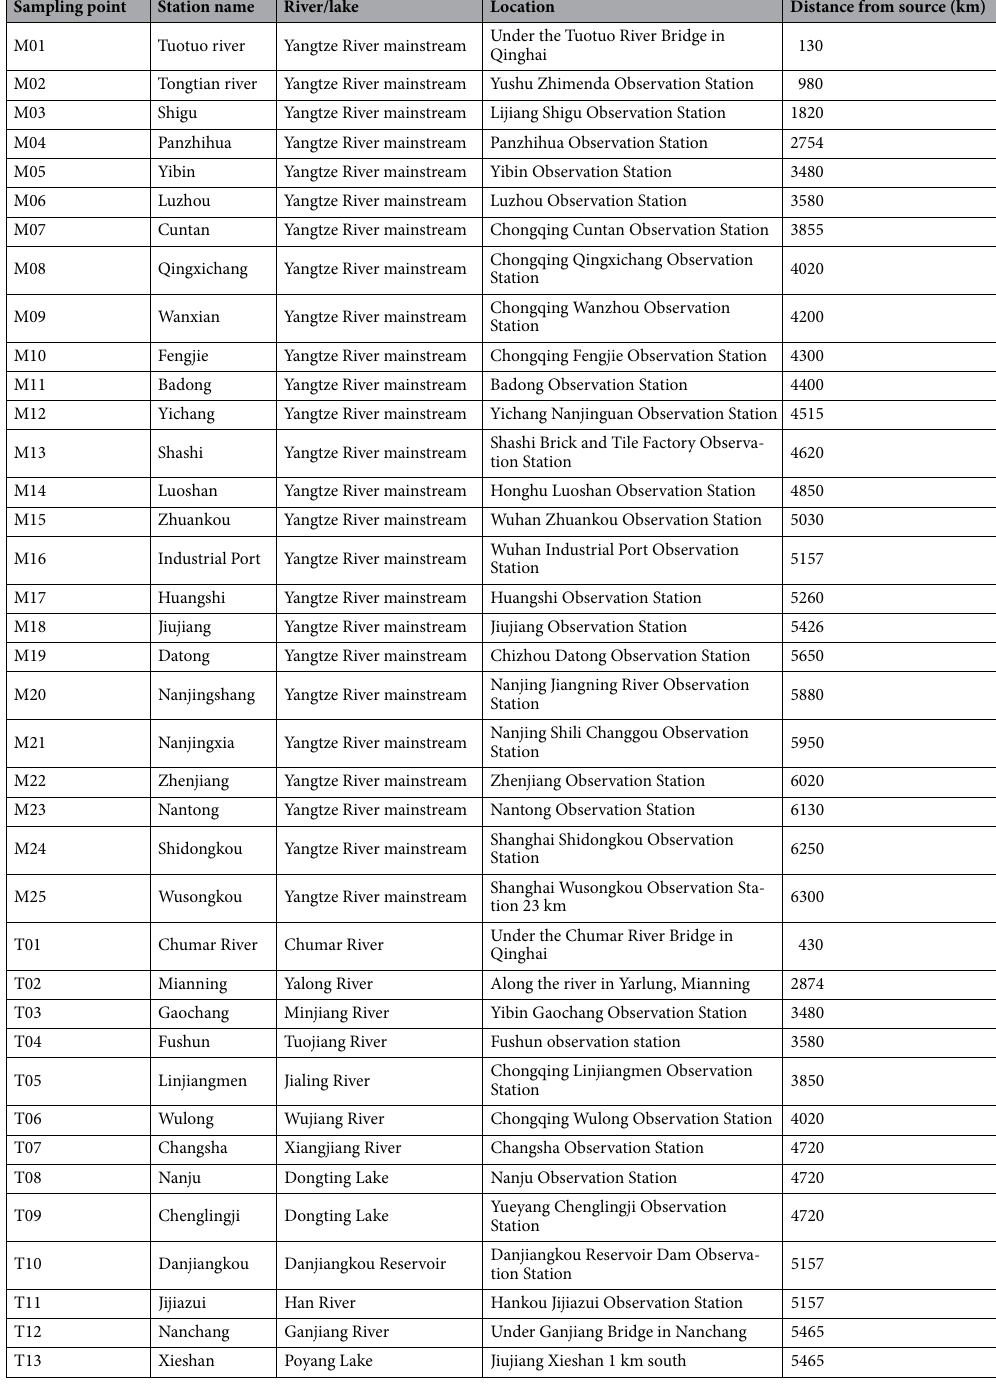
Table 1. Sampling points of suspended sediment in the main stream and tributaries of the Yangtze